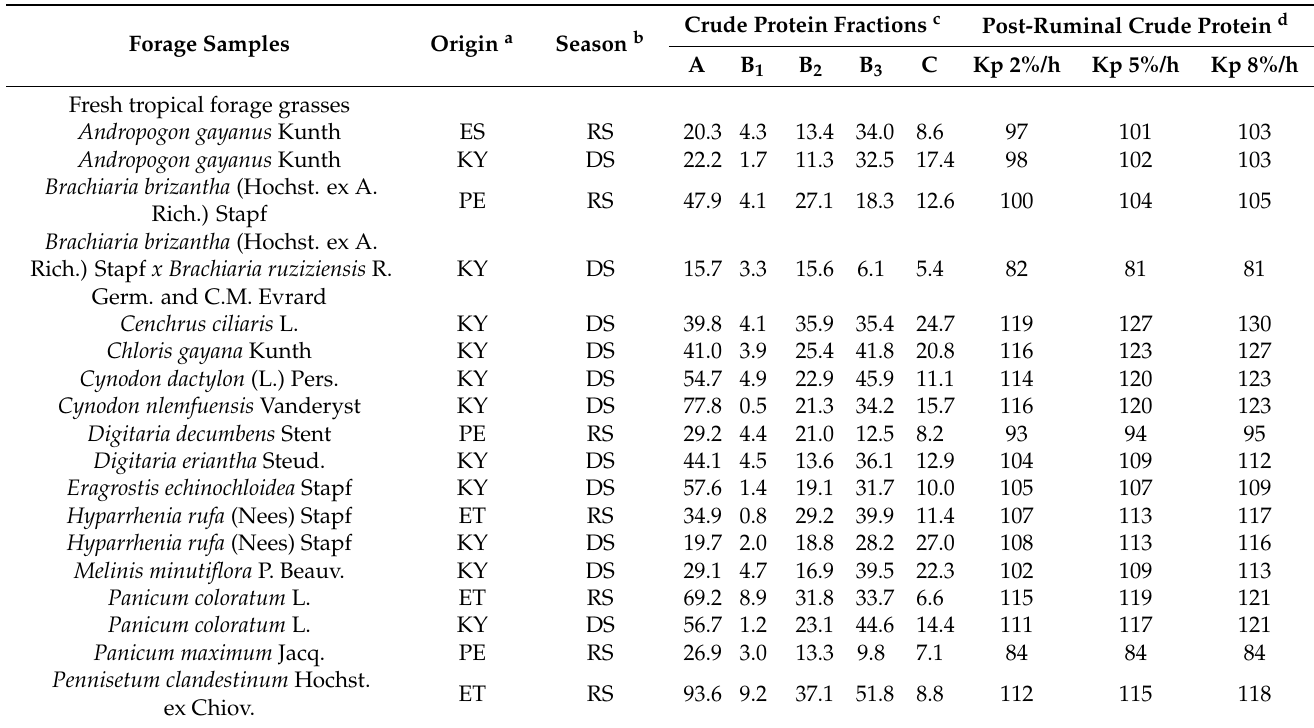
Table A1. Concentrations of crude protein fractions and post-ruminal crude protein supply determined using Lebzien et al. [15] equation of forages commonly used in tropical and subtropical ruminant husbandry systems at rumen passage rates of 2, 5, and 8%/h (all in g/kg dry matter). Forage